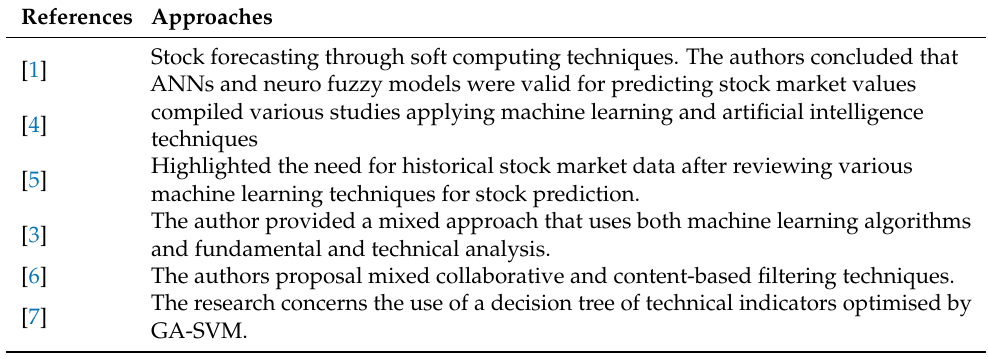
Table 1. State of the art of AI applied to Stock investment